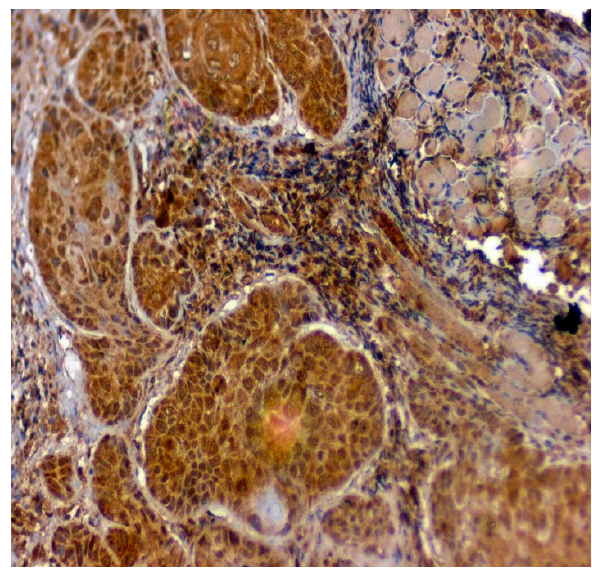
257 Figure 6. IHC for CA1 in OSCC samples (under 20× magnification). The expression of 14-3-3 ε was studied in 130 patients, of which 81.5% (106/130) were found to be expressing 14-3-3 ε . There was a significant correlation ( p = 0.000; χ 2 = 33.600) with expression among normal vs. OSMF vs. OSMF vs. OSCC patients. Table 4 shows the details of 14-3-3 ε expression, which correlated with clinicopathological parameters. We found a statistically significant overexpression ( p = 0.019; χ 2 = 5.496) with increased age (>43 years), atrophic epithelium ( p = 0.011; χ 2 = 13.149) and increased degrees of inflammation ( p = 0.041; χ 2 = 8.252). Figure 7 shows the negative immunoexpression of 14-3-3 ε in normal samples. Figure 8 shows the 14-3-3 ε -positive immunoexpression in epithelial cells in OSMF samples, with cytoplasmic and nuclear positivity. In OSCC samples, 14-3-3 ε demonstrates strong cytoplasmic and nuclear positivity in malignant epithelial cells (Figure 9). 269 270 Table 4. Clinical histopathological features in 14 ‐ 3 ‐ 3 ε‐ positive and ‐ negative groups of OSMF, OSCC and normal 271 patients. 272